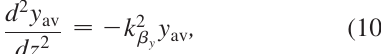
¼ (cid:1) y ffiffiffi p 2 ¼ (cid:9)(cid:2) =K , where K is (cid:1) y u y y c 2 is the normalized e (cid:9) L , i.e., the slow (cid:1) y u